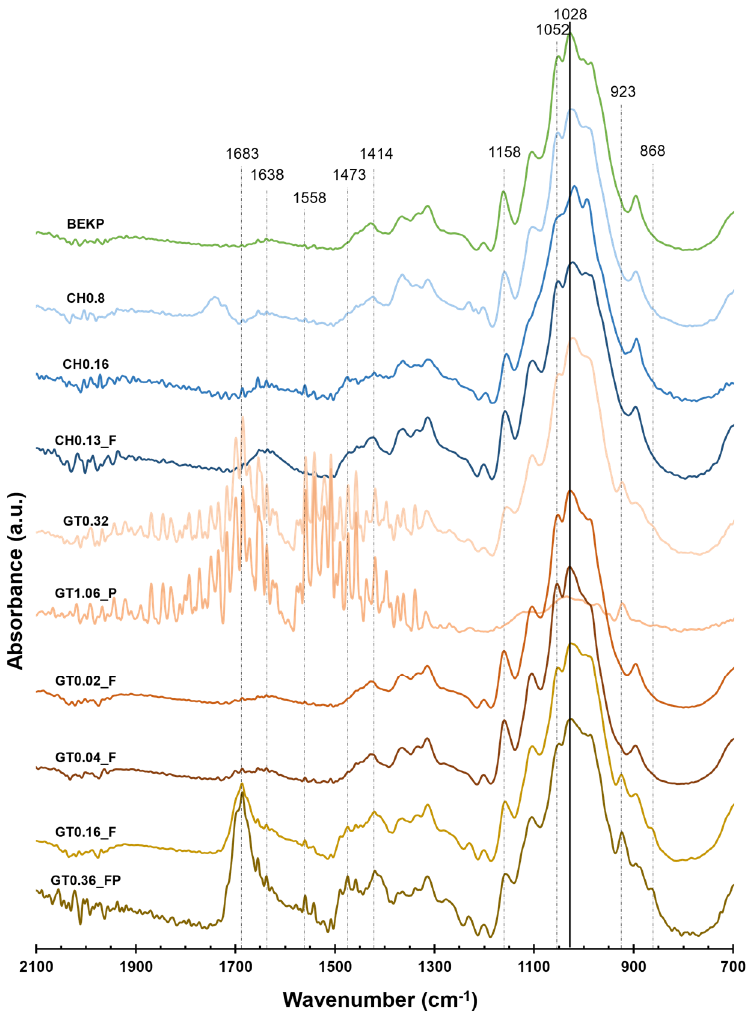
Figure 3. The FTIR-ATR spectra of the original BEKP and celluloses cationized with CHPTAC and GT. The chemical modifications induced in the cellulose were analyzed by